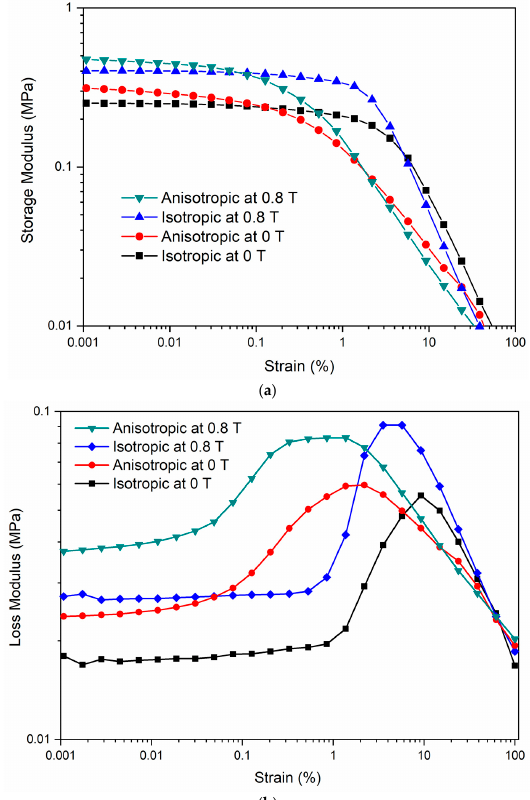
Figure 5. ( a ) Storage modulus and ( b ) loss modulus of MRE under different magnetic flux densities as a function of strain amplitude.